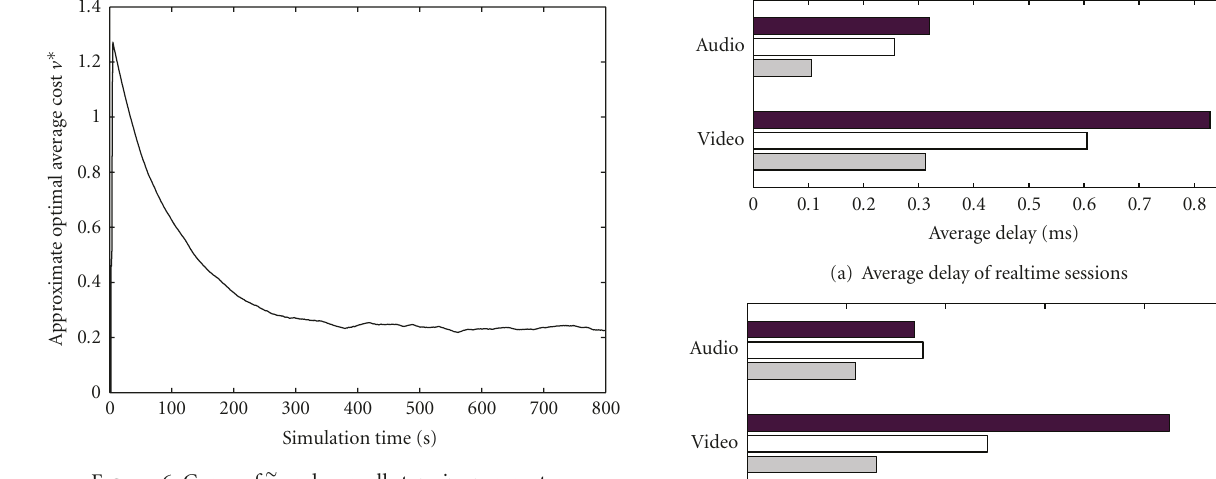
Figure 6: Curve of (cid:12) v under small step size parameters.